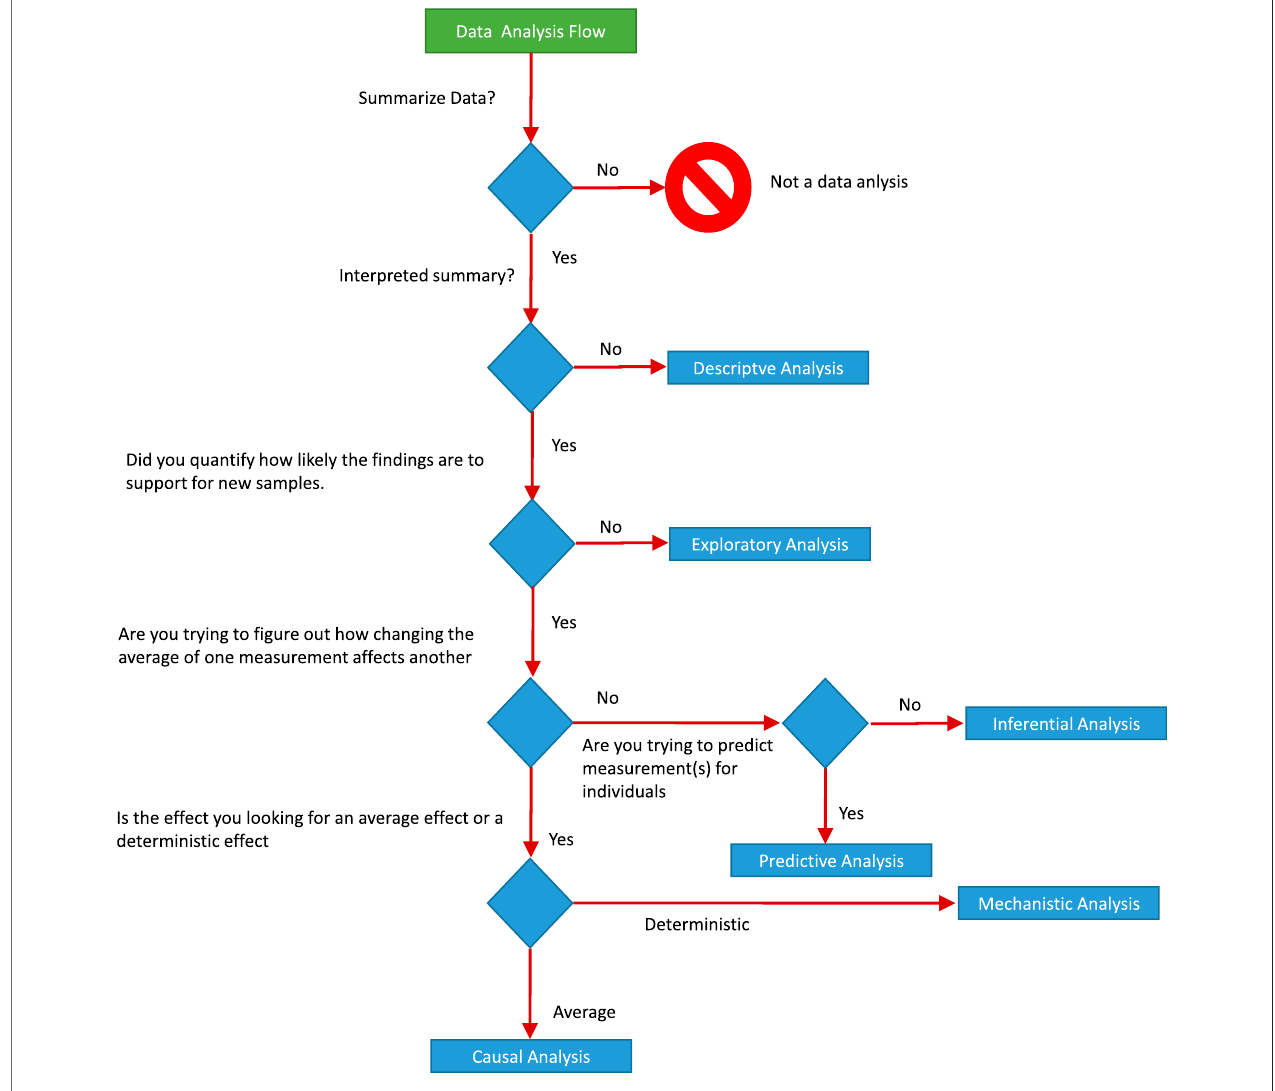
FIGURE 6 | Schematic diagram showing data analytics process. Connections are shown between the individual analysis steps that constitute the whole project Lee et al., 2019.